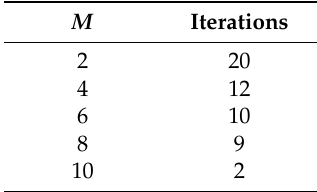
Figure 7. The comparison of RTTs with 5-minute simulation time.